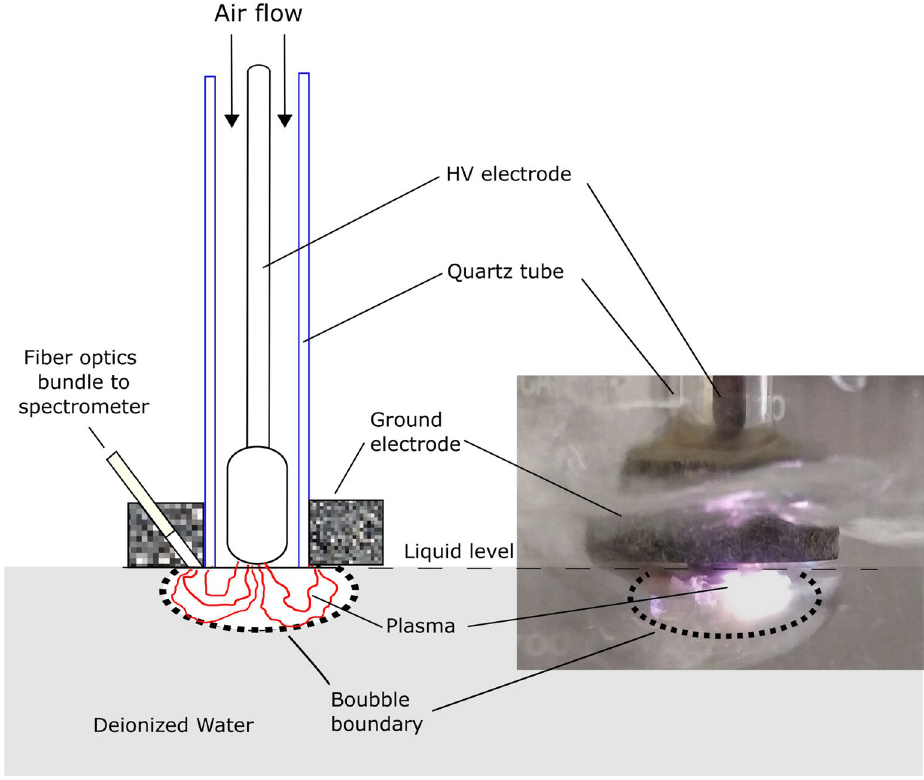
Figure 8. Experimental setup for PAW production. A cold out of equilibrium plasma is produced inside of bubbles of air. Generated with INKSCAPE 1.1 (www. inksc ape.